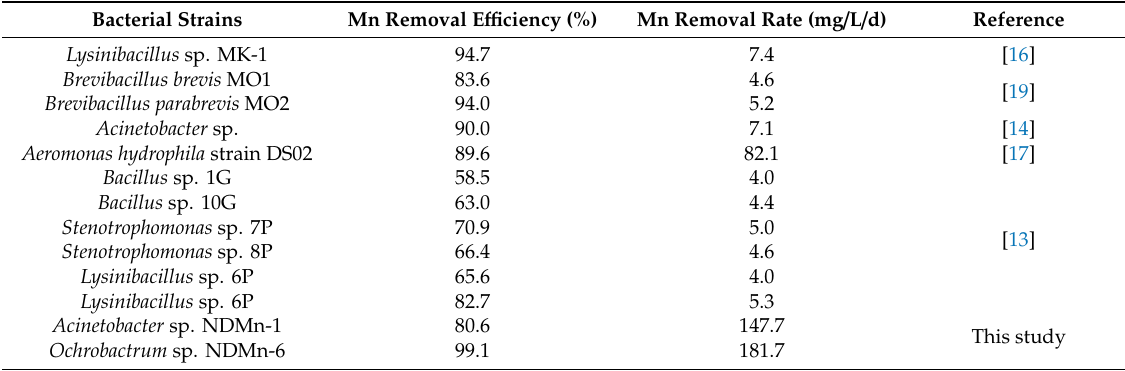
Table 3. Comparison of Mn removal e ffi ciencies and Mn removal rates by some recently reported